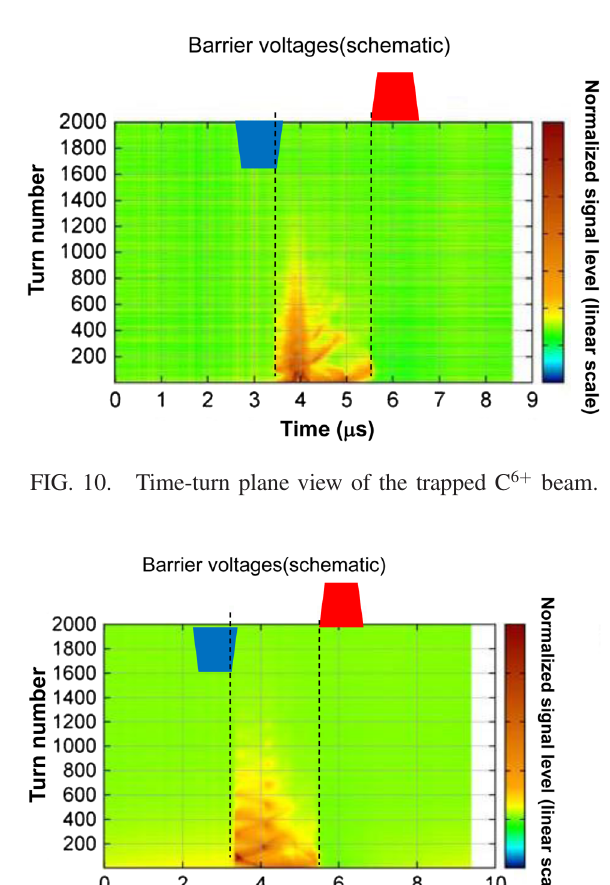
FIG. 13. Barrier voltage pulse profile with fine